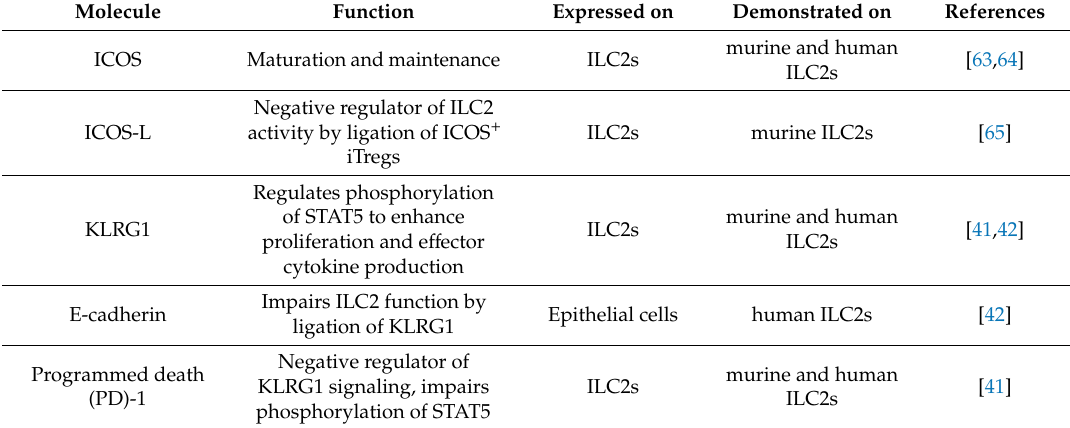
Table 1. Overview of positive and negative regulators for ILC2 activity. Even though the regulators listed here were well described for lung, skin and intestinal ILC2s, the regulatory pathways for hepatic ILC2s remain elusive. Thus, this table summarizes known regulatory mechanisms that might also modulate the function of hepatic